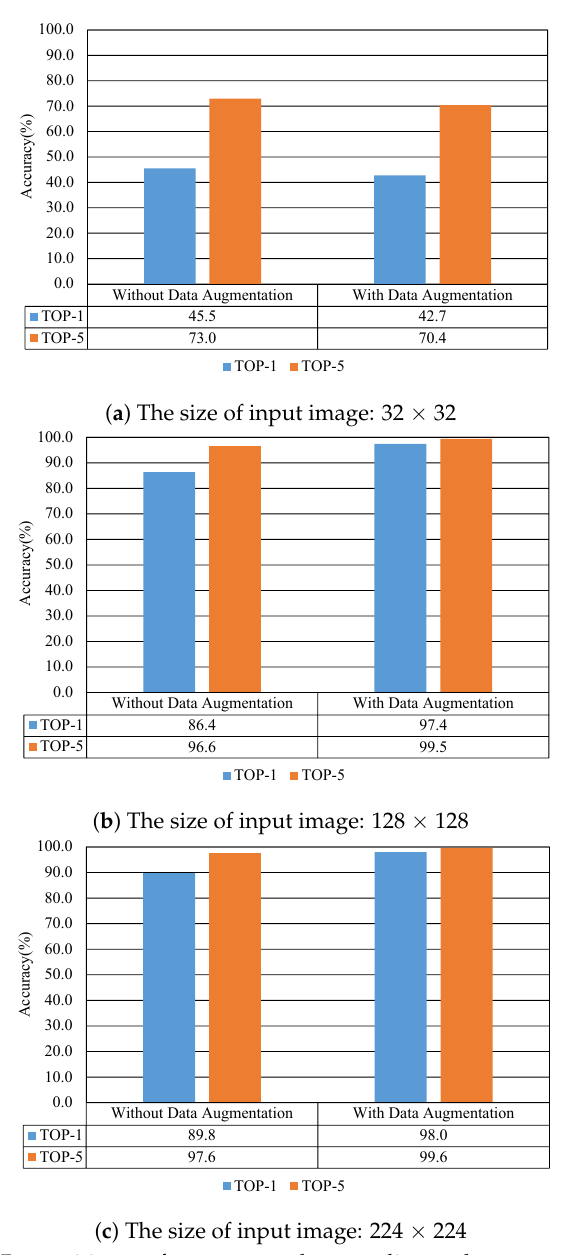
Figure 9. Recognition performance results according to data